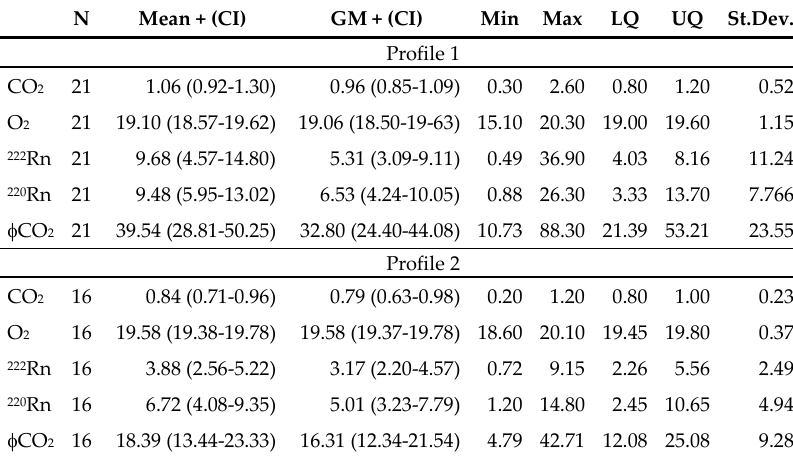
Table 1. Main statistics of soil gas data collected along the two profiles. CI, Confidence Interval; GM, Geometric Mean; Min, Minimum value; Max, Maximum value; LQ, Lower Quartile; UQ, Upper Quartile; St.Dev. Standard Deviation. Gas concentrations are expressed: carbon dioxide, CO 2 (%, v/v); oxygen, O 2 (%, v/v); radon isotopes, 222 Rn and 220 Rn (kBq m -3 ) and flux of CO 2 , φ CO 2 (g m -2 day -1 ). N Mean + (CI) GM + (CI) Min Max